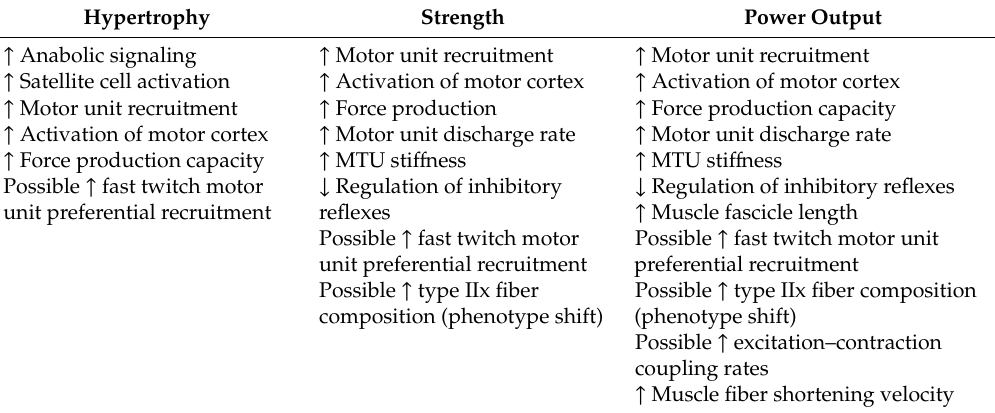
Table 1. Summary of underlying eccentric training e ff ects that may benefit hypertrophy, strength, and power